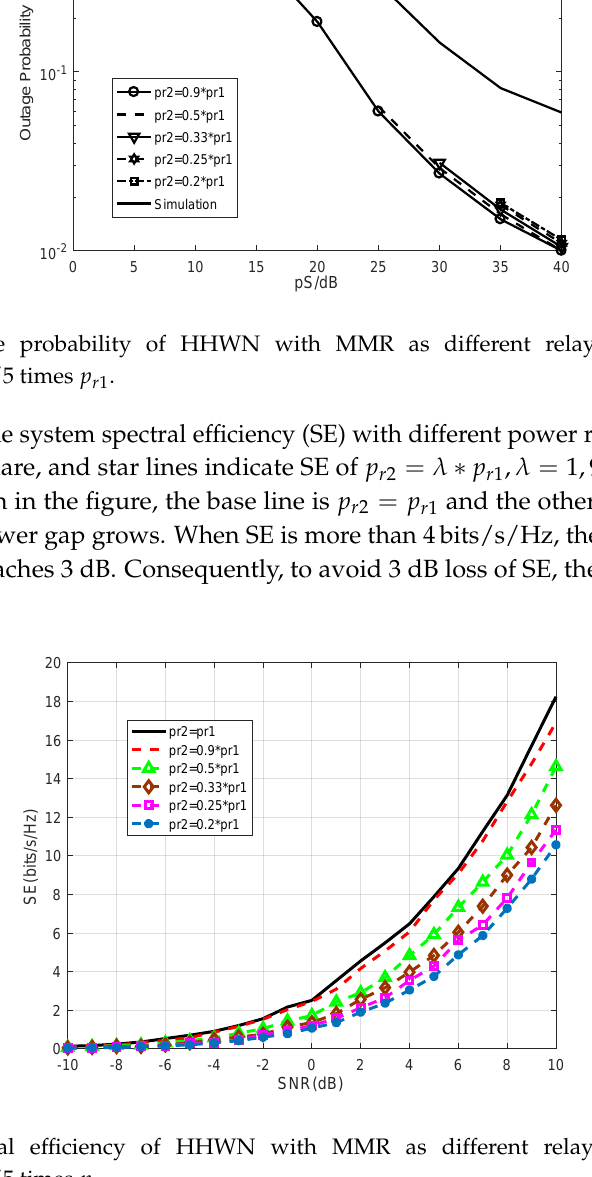
Figure 8. Spectral efficiency of HHWN with MMR as different relay power p r 2 equals 9/10,1/2,1/3,1/4,1/5 times p r 1